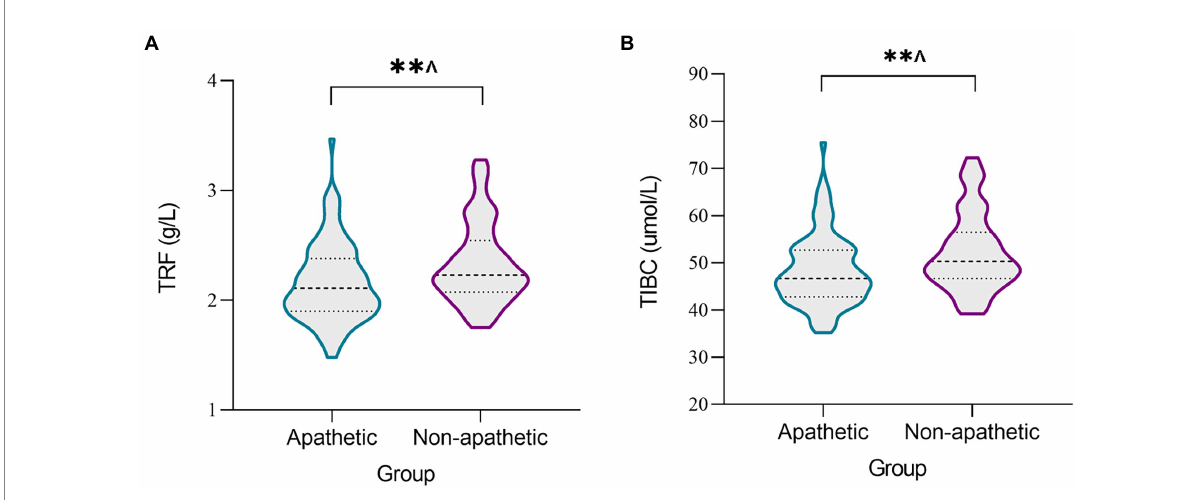
FIGURE 1 The levels of iron metabolism in serum between apathetic and non-apathetic groups. The serum concentrations of TRF (A) and TIBC (B) were lower in the apathetic group than those in the non-apathetic group. TIBC, total iron binding capacity; TRF, transferrin. ** p < 0.01. ^ The p -value was survived after Bonferroni correction ( p < 0.05/21 = 0.0024).